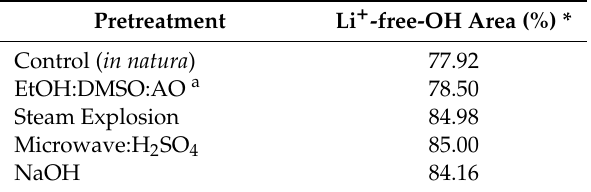
Table 2. Percentage of -OH sites uncovered by Li +